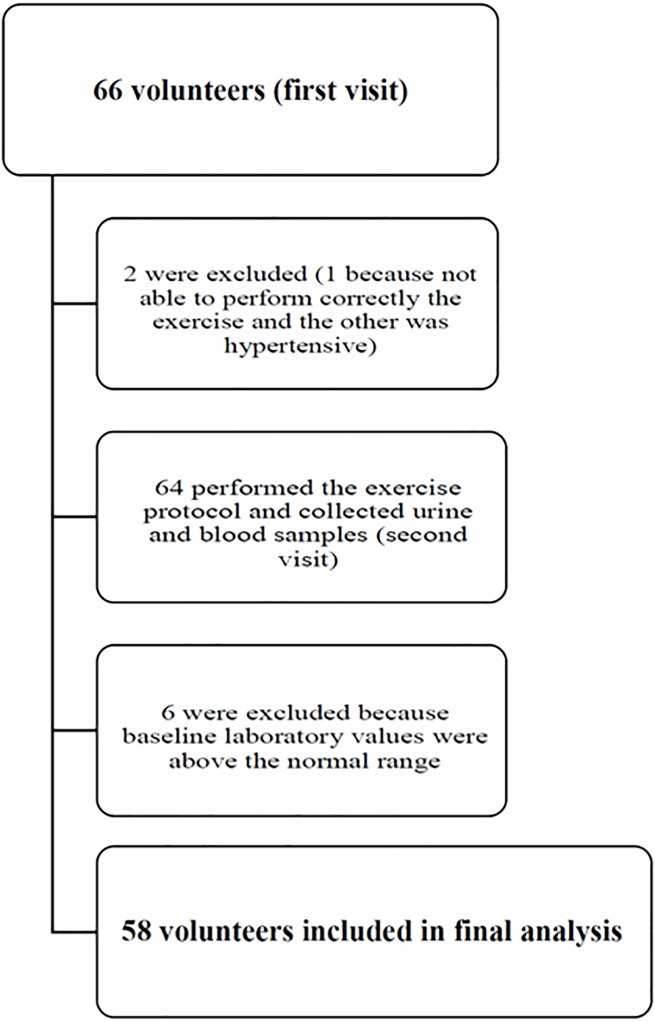
Enrollment chart of volunteers in the study.